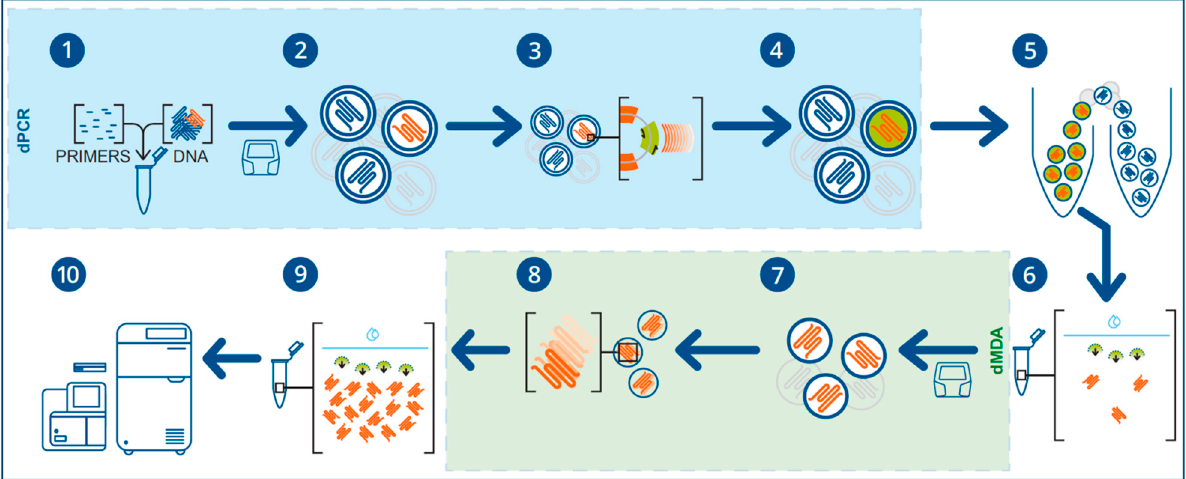
Figure 7. Schematic illustration of the steps of the microfluidic technique for indirect sequence capture (Samplix Xdrop ® ) [23] . Figures reprinted with permissions. capture (Samplix Xdrop ® )